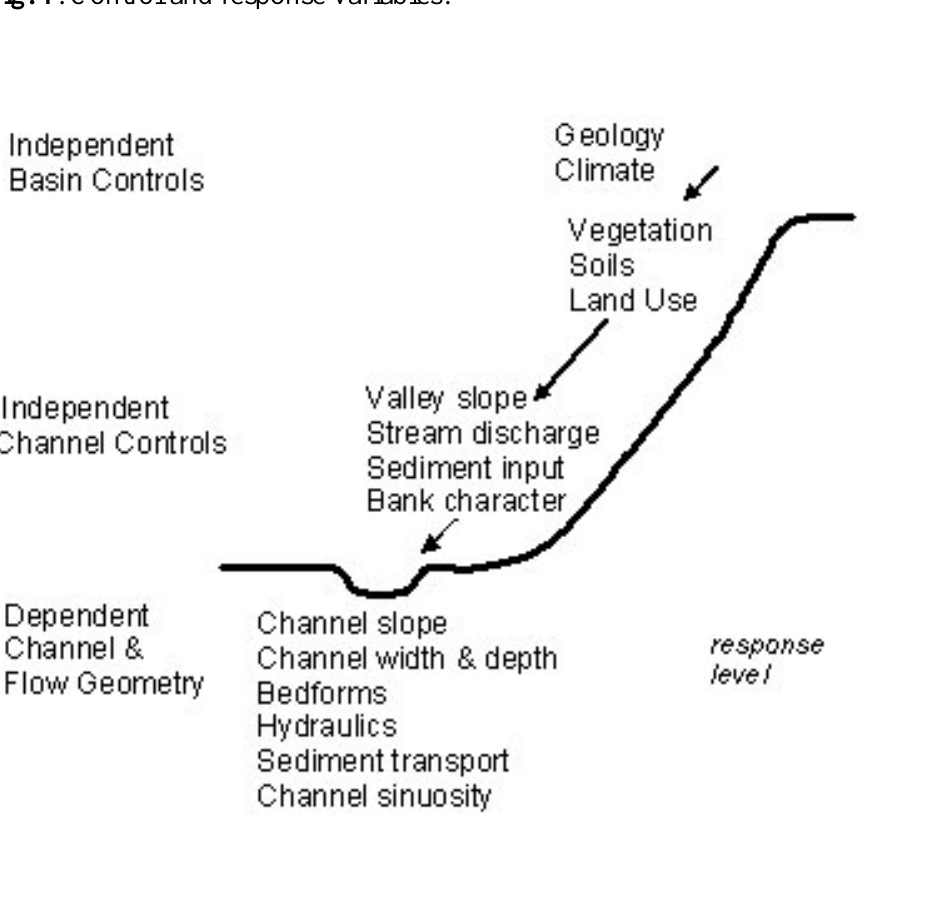
Fig. 1 . Control and response